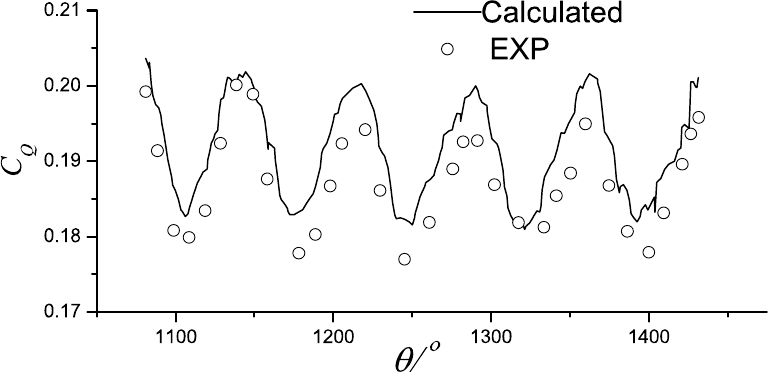
Figure 12. Turbine C ( V = 1.2, λ = 1.65, Z = 5).